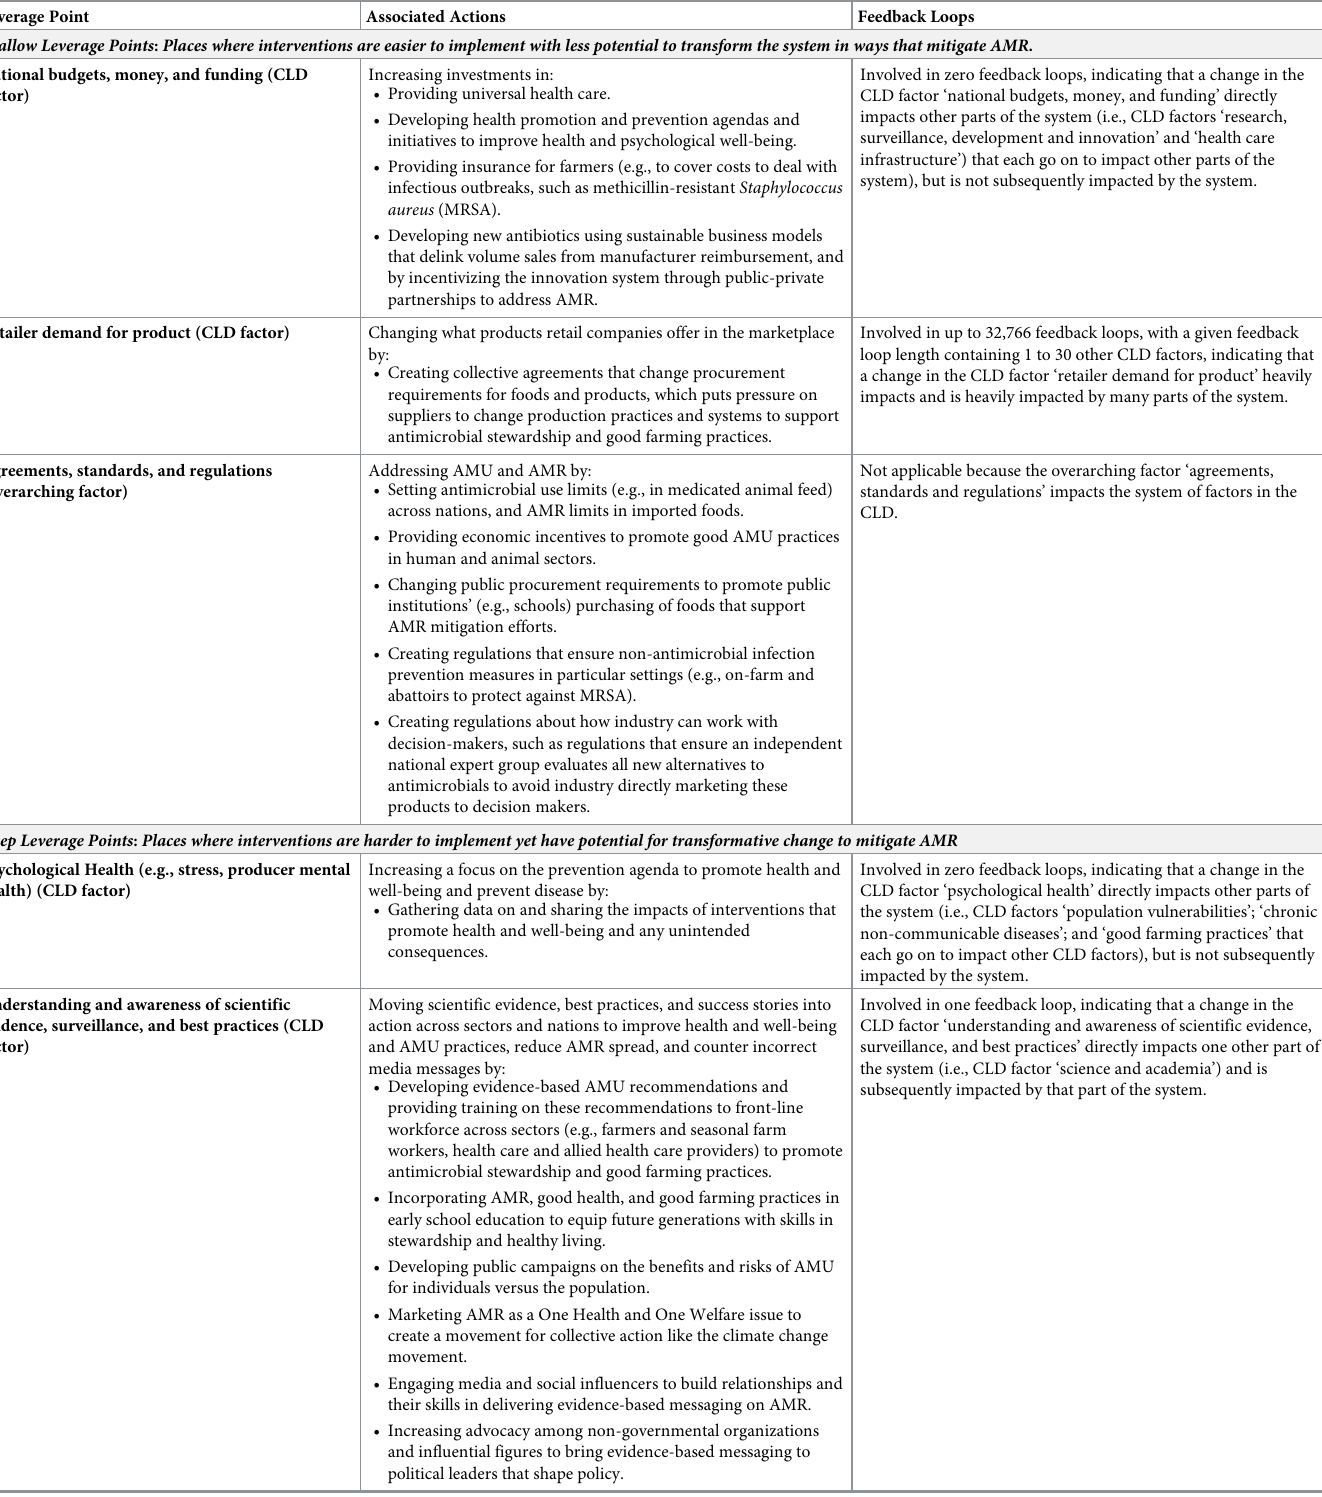
Table 2. Shallow and deep leverage points, associated actions, and feedback loops. Leverage